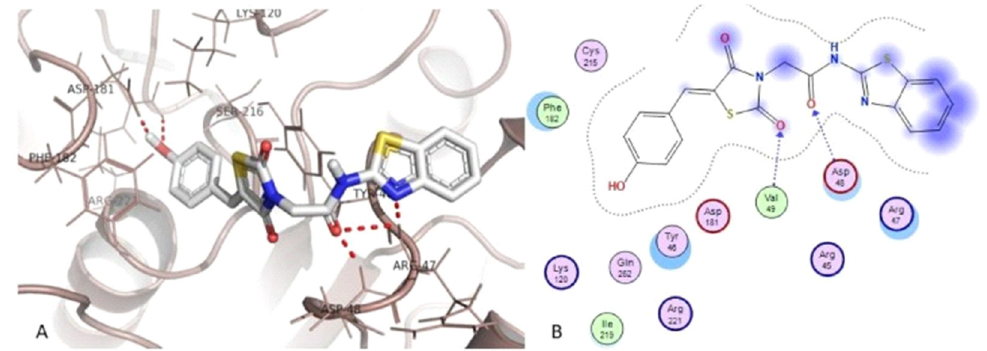
Figure 44. ( A ) Three-dimensional (3D) docking pose of compound 108a bind to the catalytic site of PTP1B and simultaneously to the second aryl phosphorylate site. ( B ) Two-dimensional (2D) diagram of docking pose of compounds 108a .